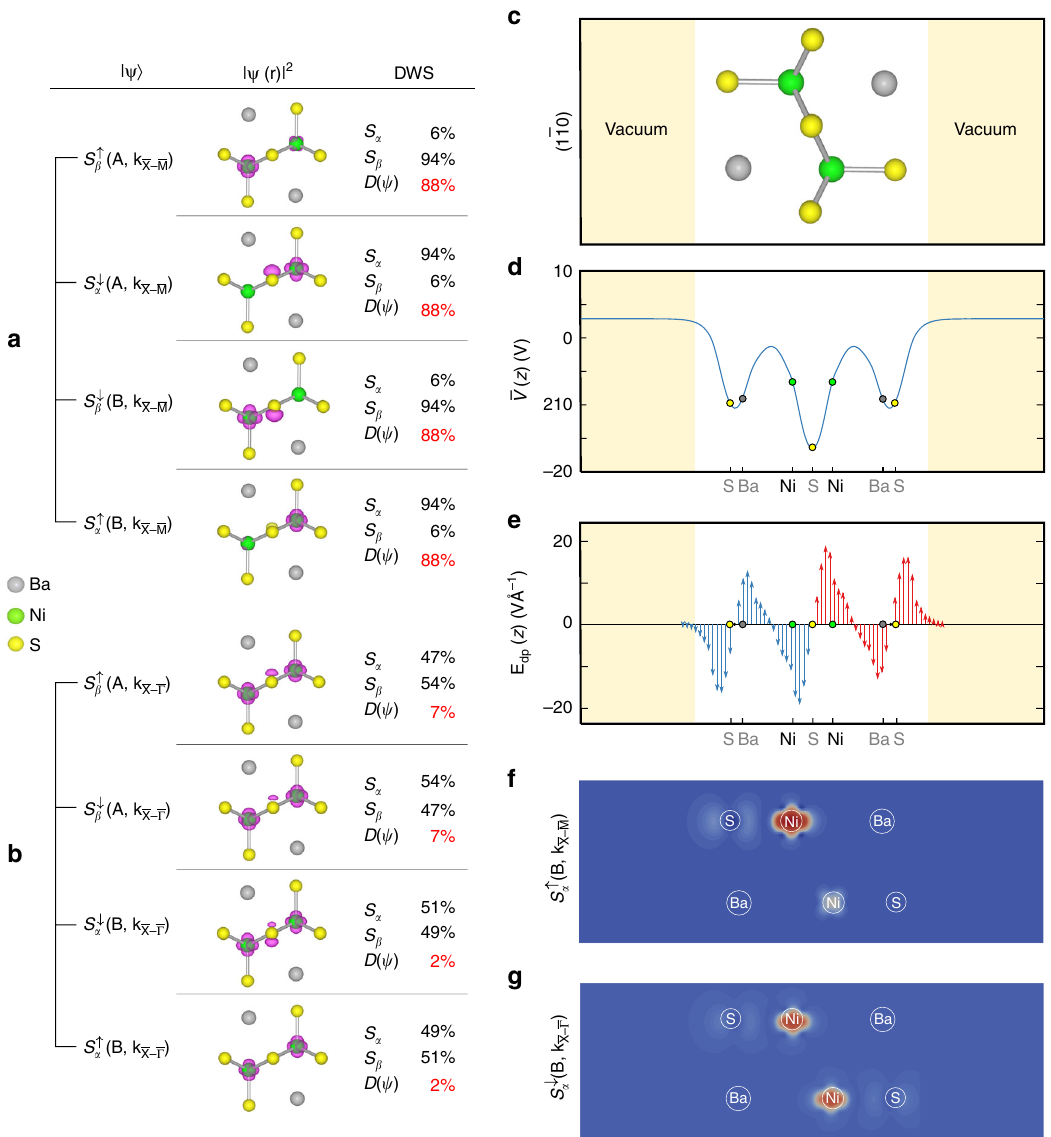
¼ Fig. 2 Wavefunction segregation and local dipole fi elds in BaNiS 2 monolayer. a , b Charge density of the lowest four conduction bands at k (cid:1) X (cid:1) (cid:1) Γ ¼ 0 : 025 ; 0 : 5 ; 0 ð Þð 2 π = a Þ , respectively. The isosurface of charge density is represented by purple. The Ni, S, and Ba atoms 0 ; 0 : 475 ; 0 ð Þð 2 π = a Þ and k (cid:1) X (cid:1) (cid:1) M are represented by green, yellow, and gray balls, respectively. The degree of wavefunction segregation and the percentage of the charge density localized on the sectors S α and S β are also listed for each state. c The crystal structure of the monolayer BaNiS 2 , a view perpendicular to the (11 ̄ 0) plane. d Planar- ð z Þ ¼ 1 = e ð Þ ∂ (cid:1) V z ð Þ = ∂ z along the z -direction. Red averaged crystal potential of the monolayer BaNiS 2 . e The z -component of the internal local dipole fi elds E dp Þ arrows indicate the dipole fi elds within the sector S α and blue arrows for the dipole fi elds within the sector S β . f , g Charge density of the S " α ð B ; k (cid:1) X (cid:1) (cid:1) Γ Þ states of the monolayer BaNiS fi and S " α ð B ; k (cid:1) 2 in the absence of external X (cid:1) (cid:1) M